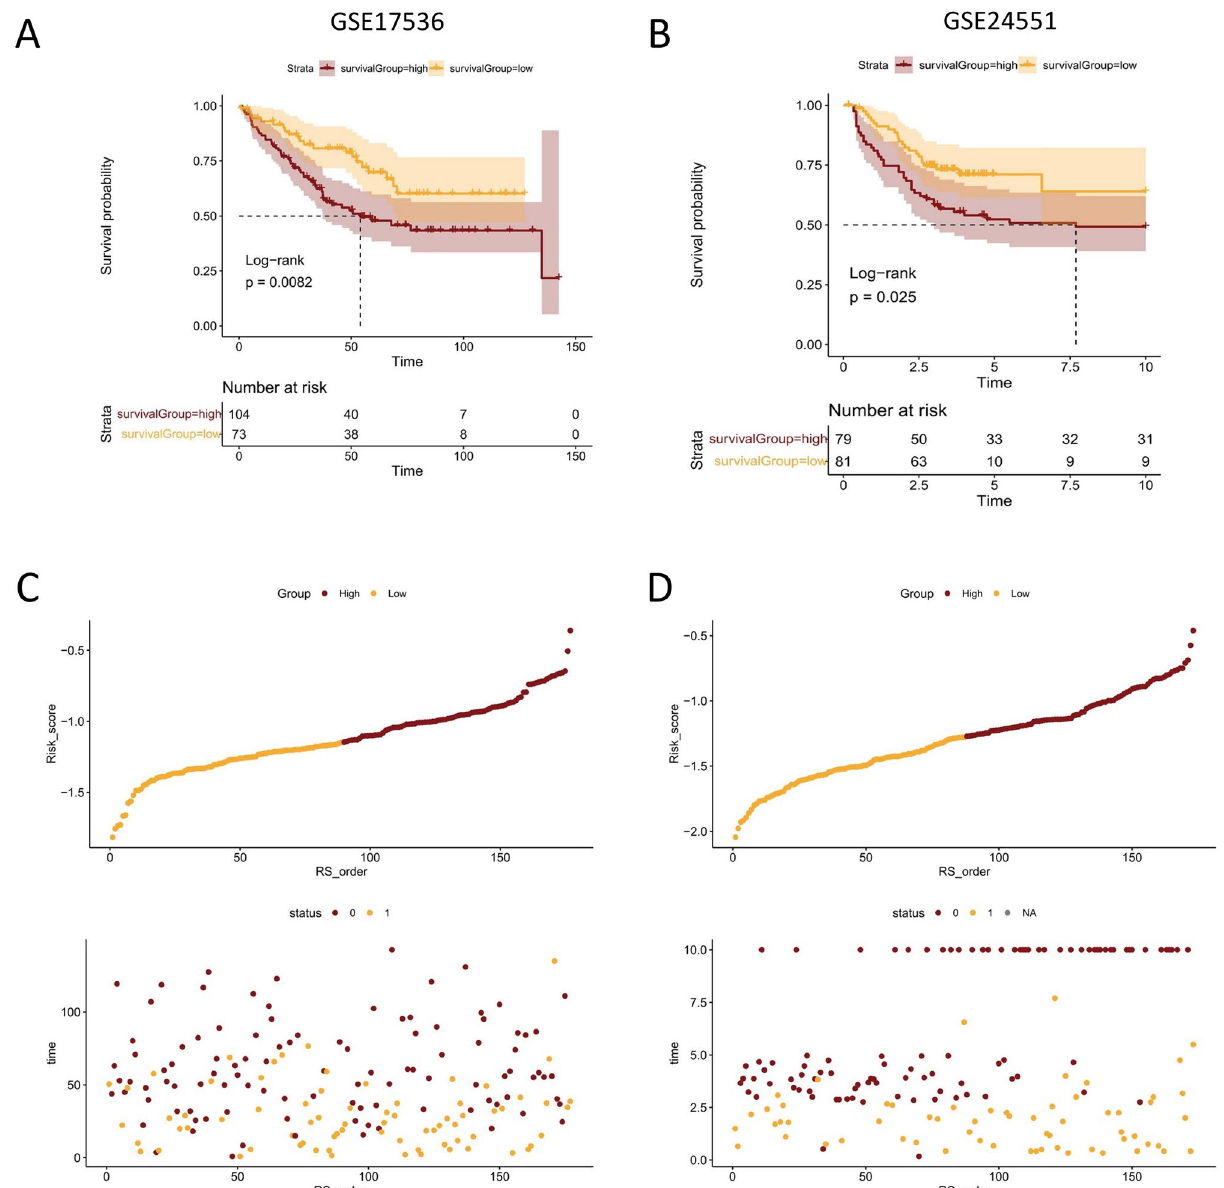
Figure 3. Validation of the prognostic signature in GSE17536 and GSE24551 cohort. ( A , B ) Kaplan–Meier survival analysis for GEO-CRC patients with high and low risk scores. ( C , D ) Risk score distribution and survival status for GEO-CRC patients in high-risk and low-risk